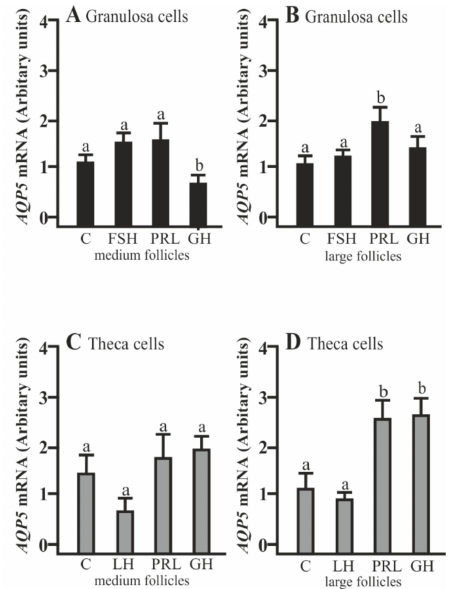
Figure 1. The changes in the expression of Aquaporin 5 (AQP5) mRNA in porcine granulosa (Gc) and theca cells (Tc) obtained from medium (MF) and large (LF) follicles after 24 h incubation in the absence (C) or presence of follicle-stimulating hormone (FSH), luteinizing hormone (LH), prolactin (PRL), and growth hormone (GH). The samples were subjected to real-time qPCR analysis and normalized to the expression of Glyceraldehyde 3-phosphate dehydrogenase ( GAPDH ) and Cyclophylin A ( PPIA ), ( A , B ) in the Gc and ( C , D ) Tc. Values are expressed as means ± S.E.M from five separate experiments, each performed in triplicate ( p < 0.05 compared with controls). Statistically significant di ff erences between treatments are indicated by di ff erent letters (a, b). C: